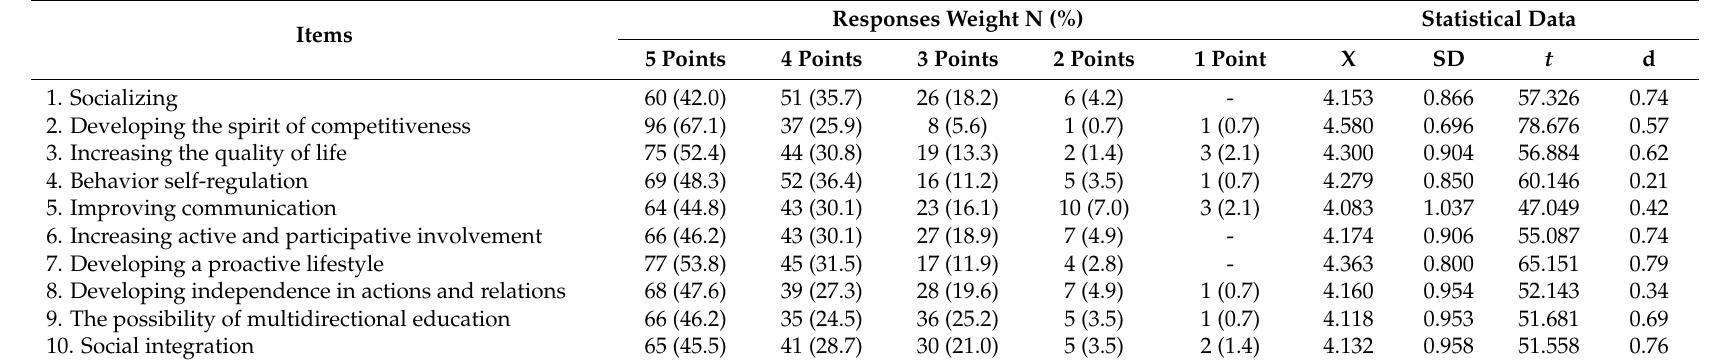
Table 3. Descriptive statistical of the social part of the questionnaire of benefits of practicing recreational figure